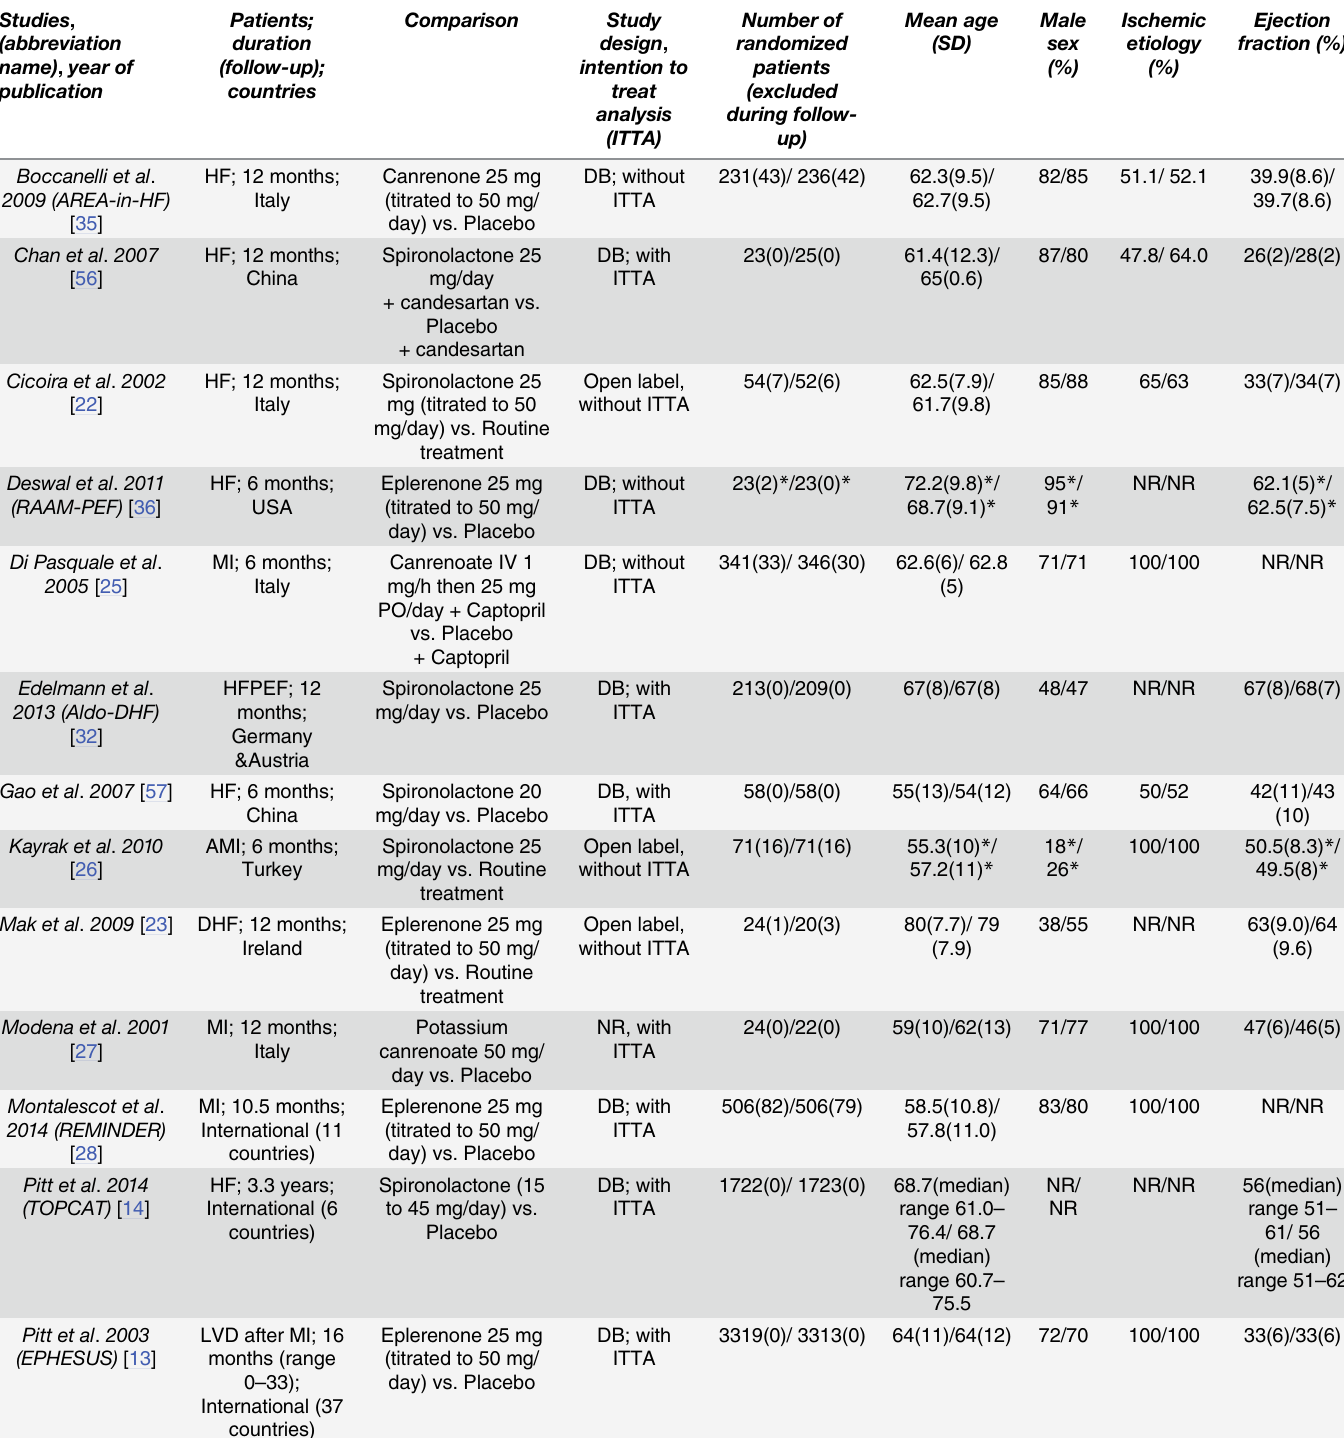
Table 1. Main characteristics of included